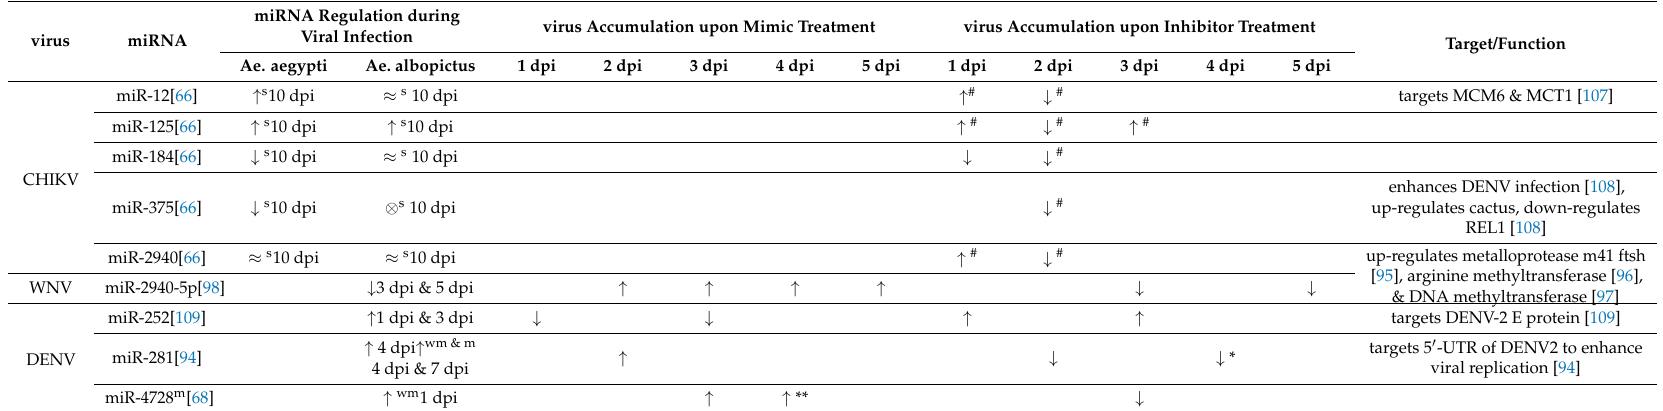
Table 3. Functional analyses of miRNAs which are differentially abundant upon virus infection. All miRNA regulation assays are tested in vivo and all virus accumulation assays are tested ex vivo unless otherwise